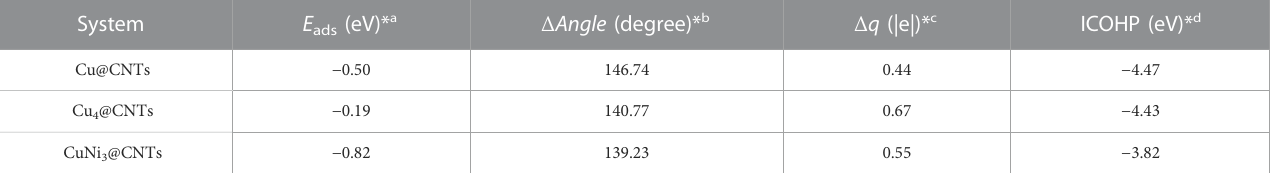
TABLE 1 Geometric and electronic structure parameters of adsorbed *CO 2 on the three Cu-based catalysts.